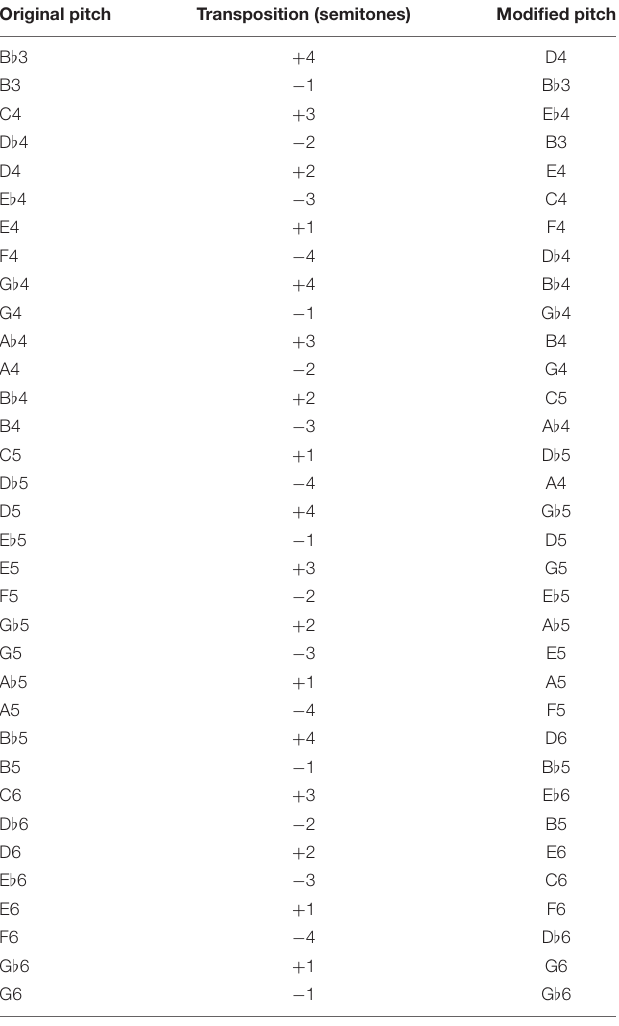
TABLE 1 | Template for generating the pitch-shifted oboe stimuli variants used in Experiment B. Original pitch Transposition